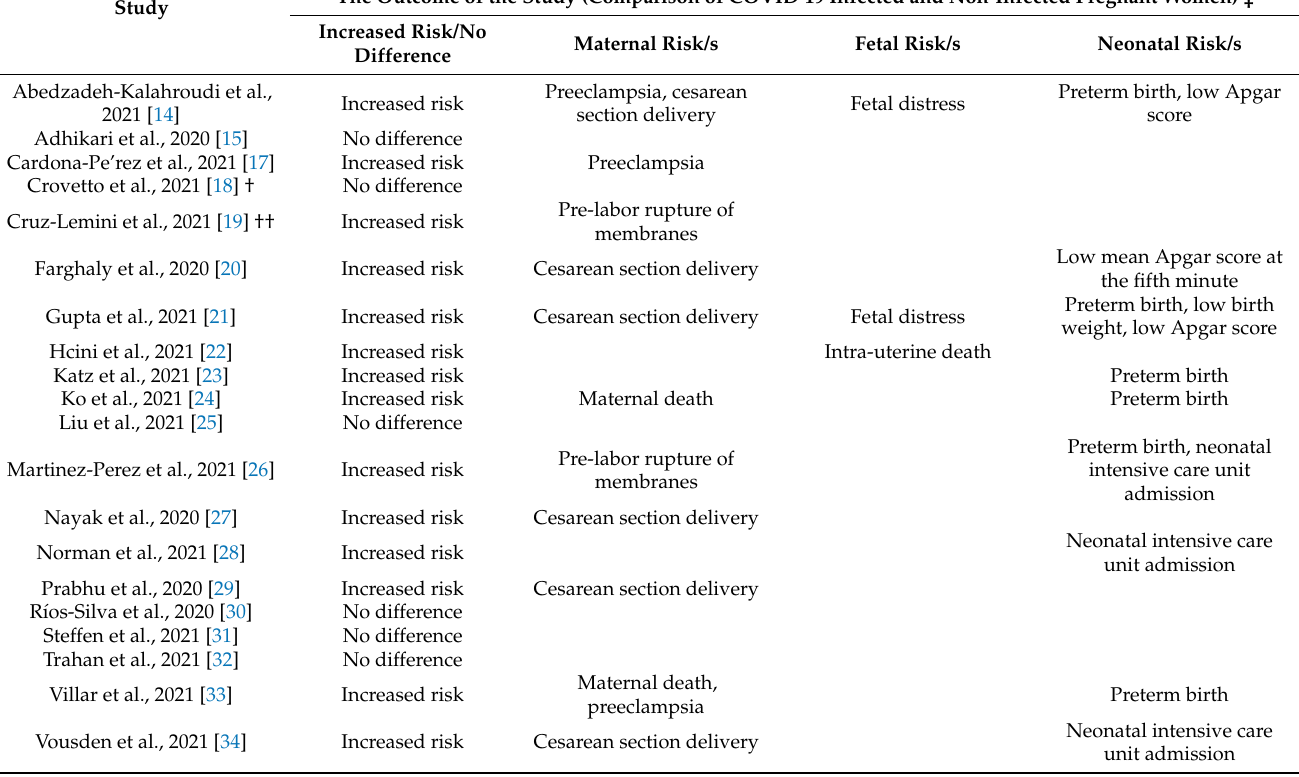
Table 3. Summary findings of individual